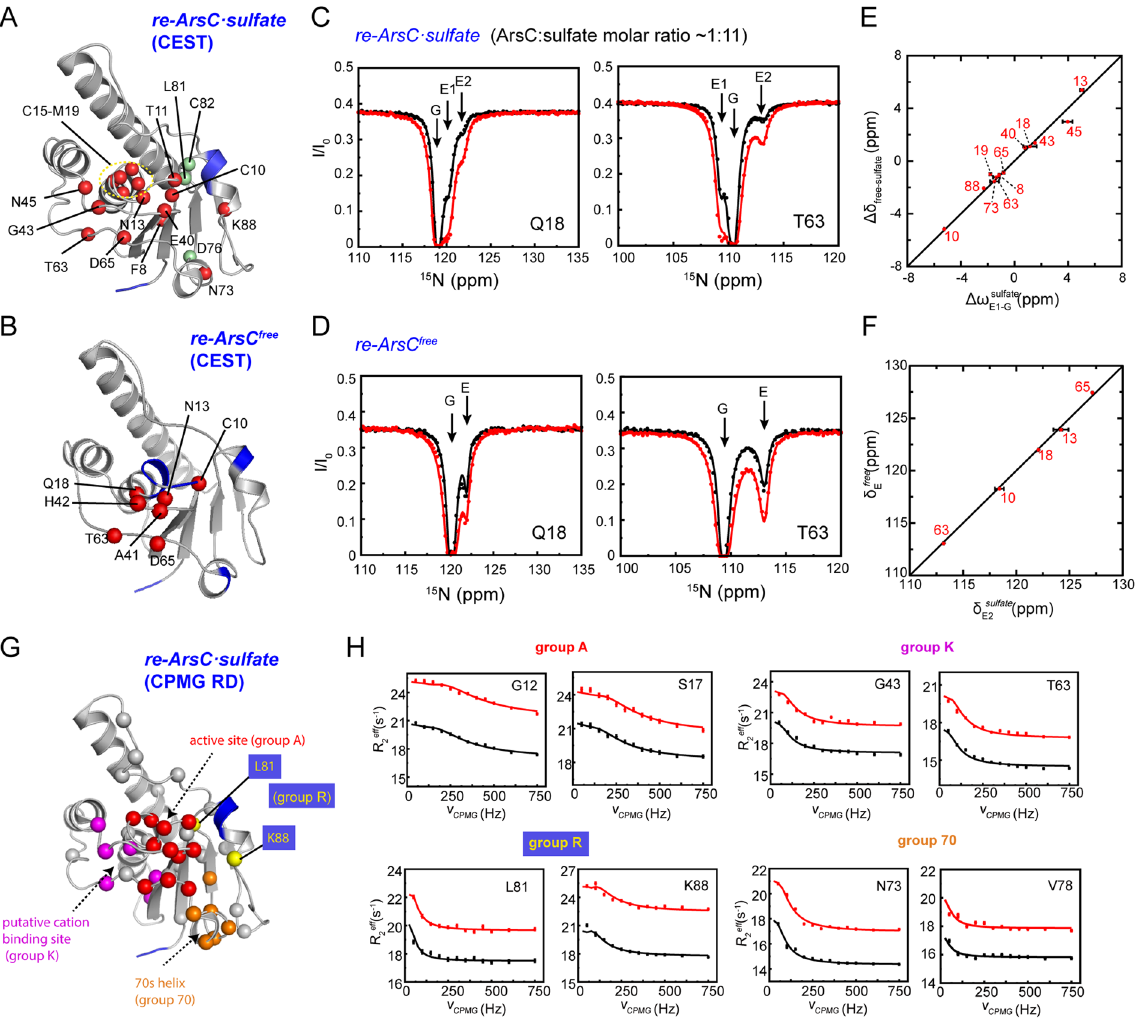
Figure 2. 15 N CEST and CPMG RD results of re-ArsC . ( A , B ) Mapping of residues showing conformational exchanges in re-ArsC·sulfate ( A ) and re-ArsC free ( B ) identified by CEST experiments onto the structure (shown as spheres). Residues showing sulfate concentration-dependent CEST profiles are shown as red balls in ( A ). Residues with missing backbone amide resonances are colored blue. ( C , D ) Representative 15 N CEST profiles in re-ArsC·sulfate ( C ) and re-ArsC free ( D ) obtained on a 600-MHz spectrometer using B 1 fields of 8.4 Hz (black) and 13.5 Hz (red). The re-ArsC·sulfate sample was prepared with ArsC concentration of 1.8 mM and sulfate concentration of 20 mM. ( E ) Comparison between the Δω values extracted from CEST experiment of re-ArsC·sulfate and the chemical shift differences Δδ free − sulfate for residues showing sulfate concentration- dependent CEST profiles. Here Δω E1-Gsulfate = δ E1sulfate − δ Gsulfate , with δ Gsulfate , δ E1sulfate corresponding to the chemical shifts of the major and first minor dips in re-ArsC·sulfate CEST profiles, respectively, and Δδ free-sulfate = free and re-ArsC · sulfate , respectively. δ − δ δ δ free sulfate , with free , sulfate corresponding to the chemical shifts in re-ArsC Residue numbers are denoted. ( F ) Comparison between the chemical shift of the E2 state in re-ArsC·sulfate ( δ E2sulfate ) and E state in re-ArsC free ( δ Efree ), with residue numbers denoted. ( G ) Mapping of residues showing conformational exchanges in the CPMG RD experiments in re-ArsC·sulfate onto the structure (shown as spheres). Residues that are included in the “A”, “K”, “R” and “70” groups are shown in red, magenta, yellow and orange, respectively. Residues with missing backbone amide resonances are colored blue. ( H ) Representative RD profiles of the four groups obtained on 600-MHz (black) and 800-MHz (red)